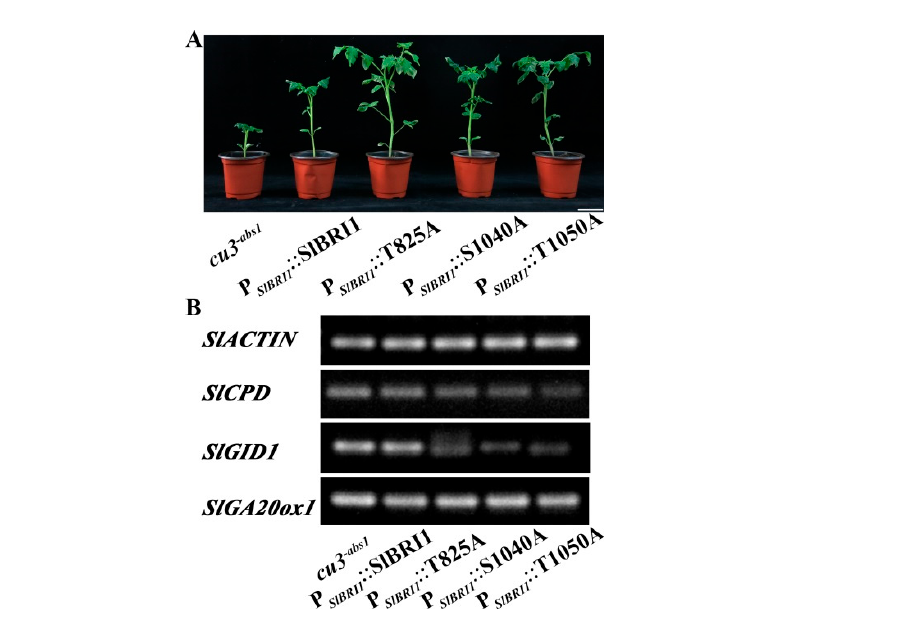
Figure 7. Comparison of the effects of SlBRI1 T825A, S1040A, and T1050A on BR and GA signaling. ( A ) Phenotypes of plants at the seedling stage (42 days after sowing), Scale bar represents 5 cm. ( B ) Relative transcript levels of SlCPD, SlGID1 , and SlGA20ox1 in the second leaves from both the transgenic and cu3 -abs1 plants at the six-leaf stage were tested by RT-PCR. SlACTIN was used as a reference gene in tomato. Each product had 3 biological replications.